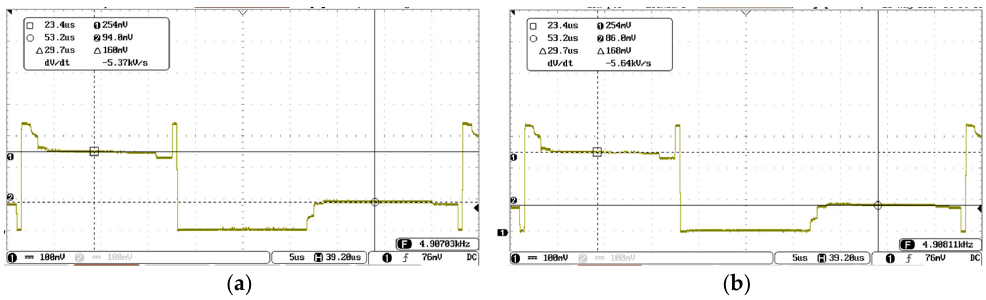
Figure 9. One-layer design: ( a ) “released” signal; and ( b ) “pressed” signal.